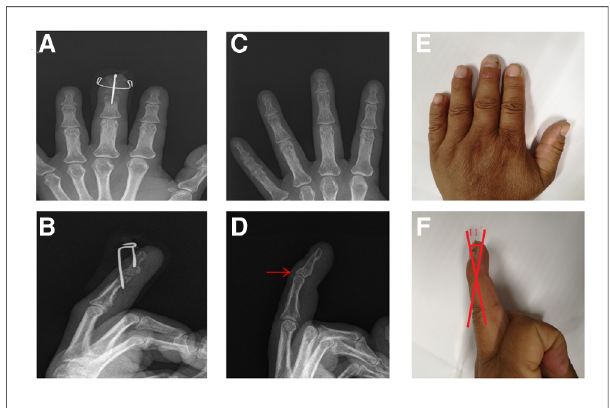
FIGURE 5 Follow-up of patient No.7. ( A,B ). X-ray at 8 weeks postoperatively. ( C,D ). X-ray at 24 weeks postoperatively;malunion (red arrow). ( E,F ). Finger appearance at 24 weeks; extension de fi cit (red